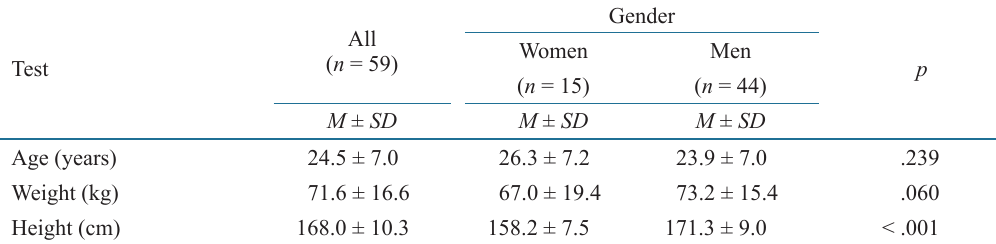
Note. M = mean; SD = standard deviation; p = statistical